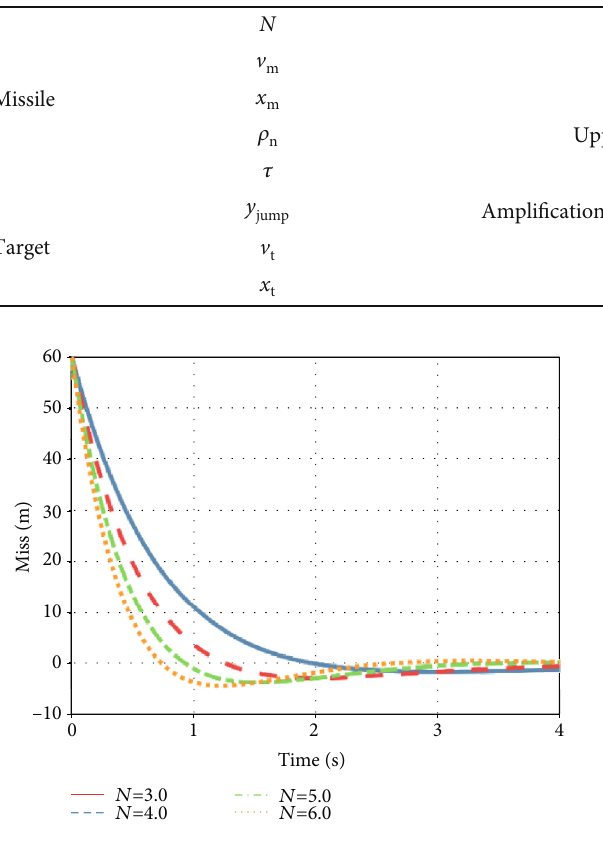
Figure 13: In fl uence of the ratio coe ffi cient on the miss distance.